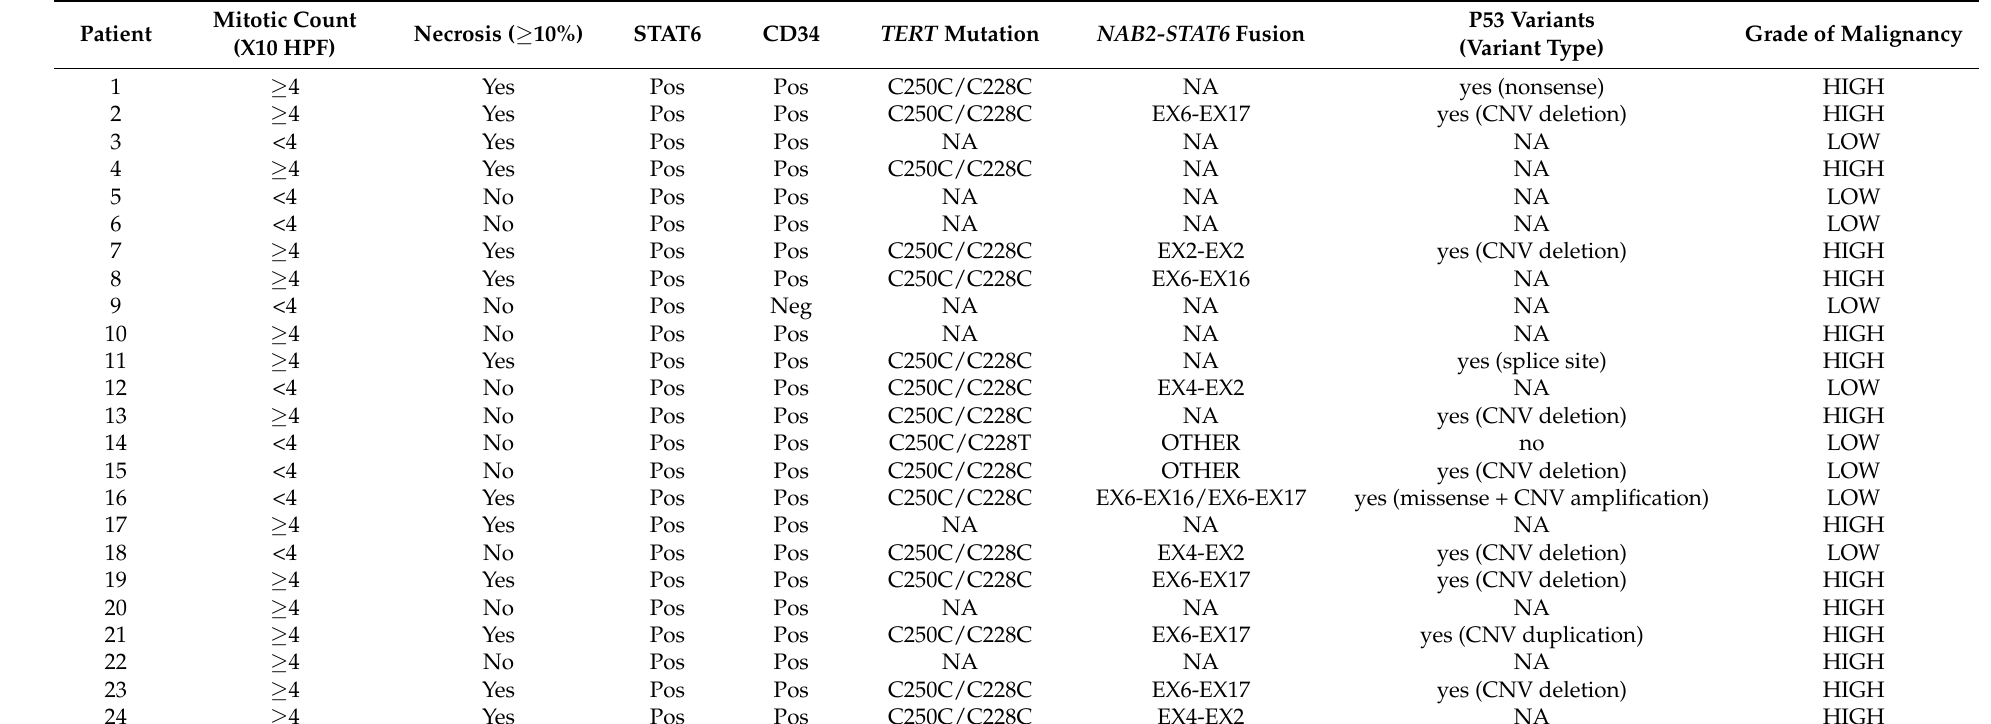
Table 2. Histopathological and molecular features of SFT